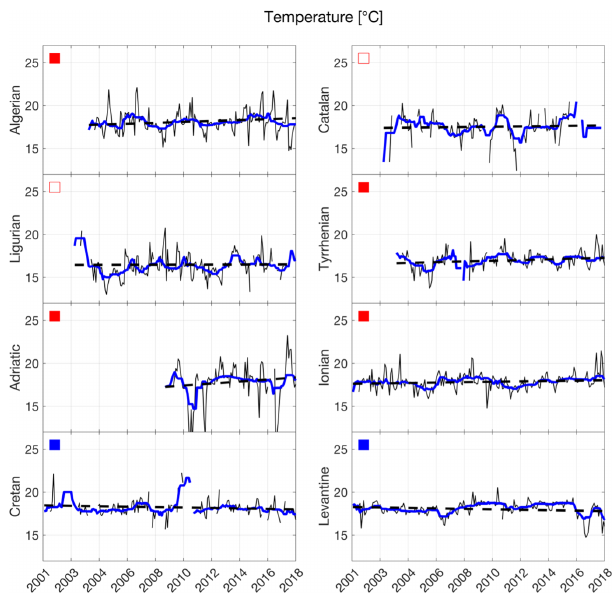
Figure 4. The same as Fig. 3 but for the AW temperature.